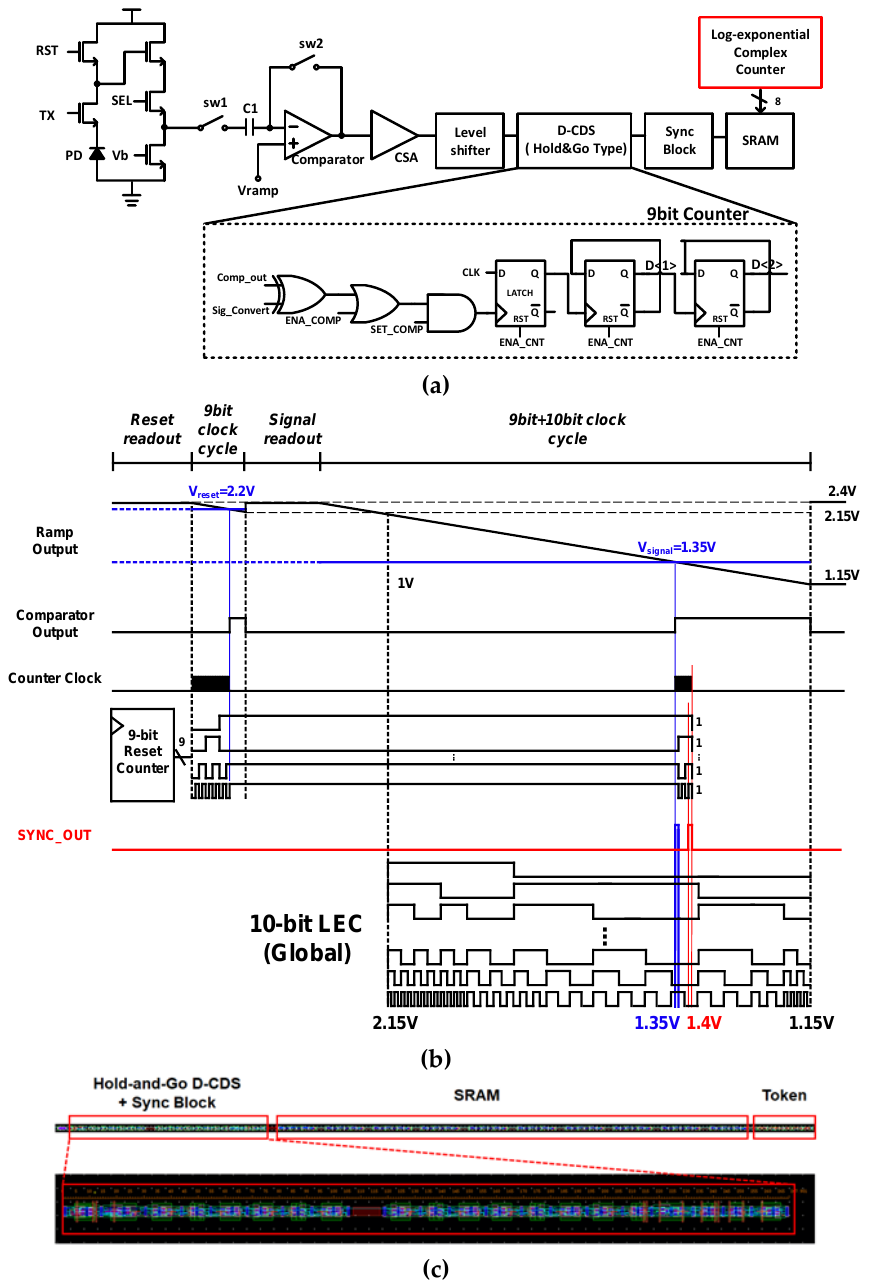
Figure 4. ( a ) Block diagram and ( b ) Timing diagram of SS-ADC with D-CDS using the HG Counter, and ( c ) 1-column layout of the HG counter and